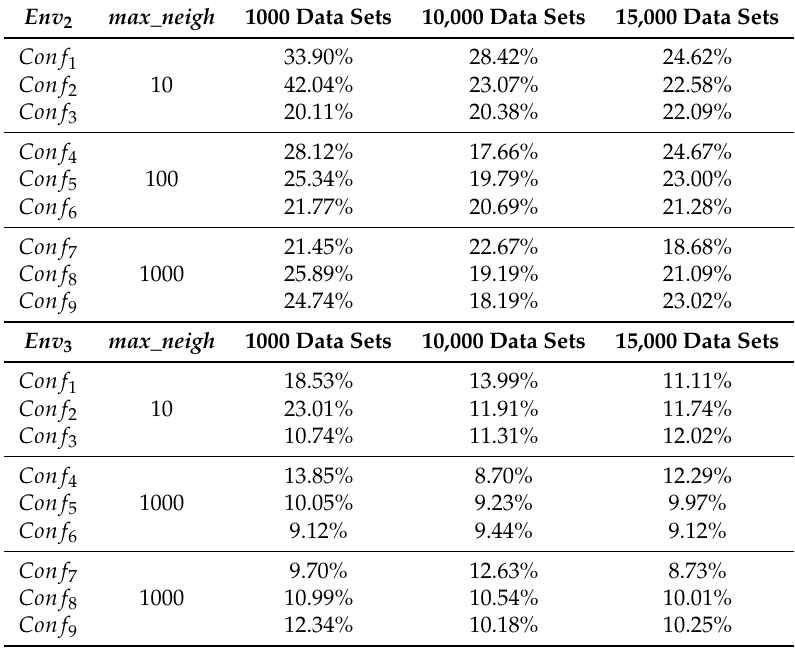
Table 10. Fraction of average execution times for environments Env 2 and Env 3 ( Spark technology) with respect to execution times for environment Env 1 ( Hadoop